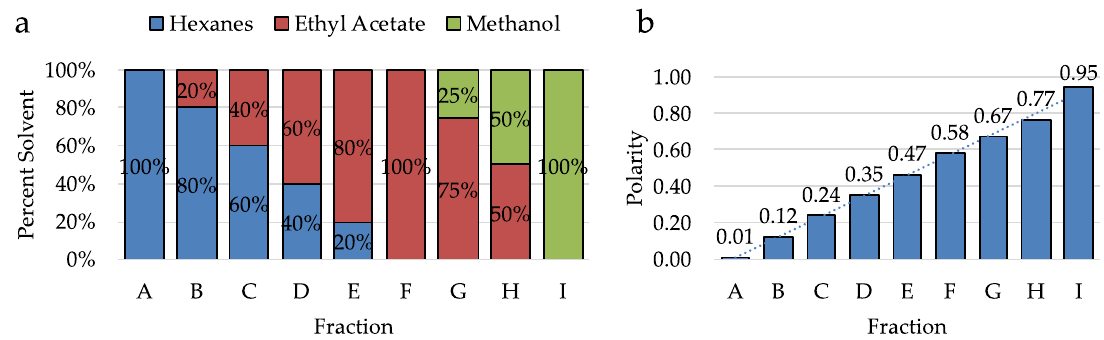
Figure 1. ( a ) Solvent system used to elute each fraction for crude fractionation. Solvent system starts with 100% hexanes for fraction A and increases in polarity through fraction I (100% methanol). ( b ) Polarity of each solvent system used for crude fractionation. The polarity of solvents increases linearly from fractions A through I.